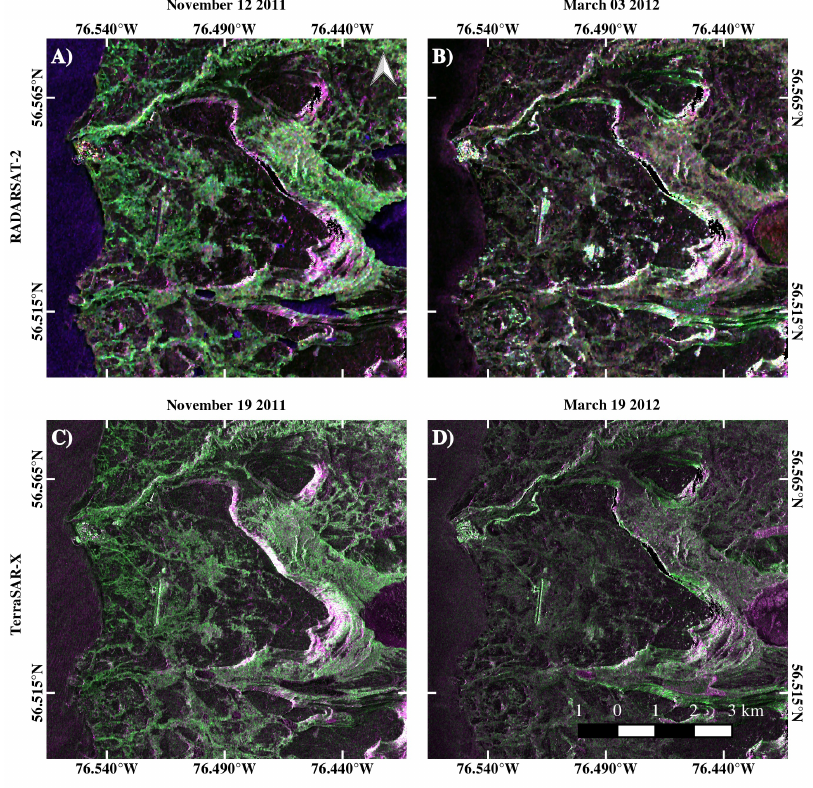
Figure 4. RGB colour composite of RADARSAT-2 and TerraSAR-X images. ( A , B ) RADARSAT-2 images taken on 19 November 2011 and 03 March 2012 at θ = 38 ◦ , red = σ 0 , green = σ 0 , blue = σ 0 . ( C , D ) TerraSAR-X images taken on 11 November HH HV V V 2011 and 13 March 2012 at θ = 38 ◦ , red and blue = σ 0 , green = σ 0 . RADARSAT-2 data HH HV c (cid:13) MDA LTD. (2011–2012). TerrSAR-X data c (cid:13) DLR